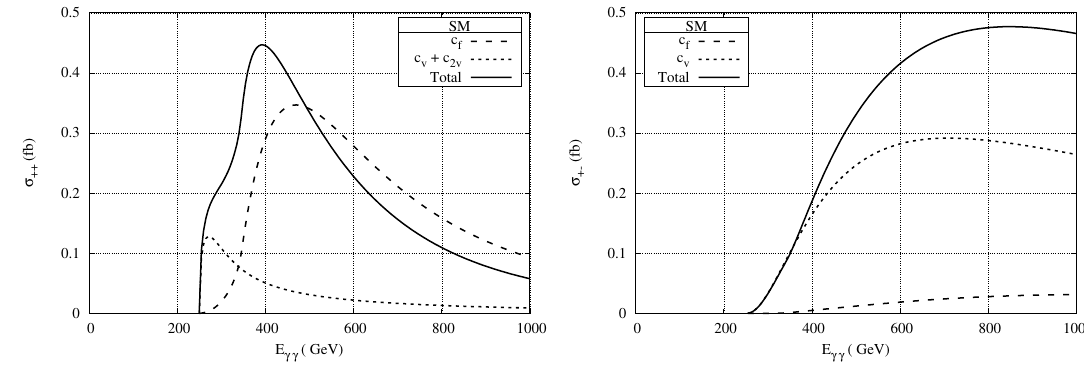
Figure 1 . γγ → hh cross-section for same photon helicities (left panel) and opposite photon helicities (right panel) in the SM. The contributions labeled c f and c v + c 2 v refer to the individual contributions of tops and gauge bosons respectively (cf. table